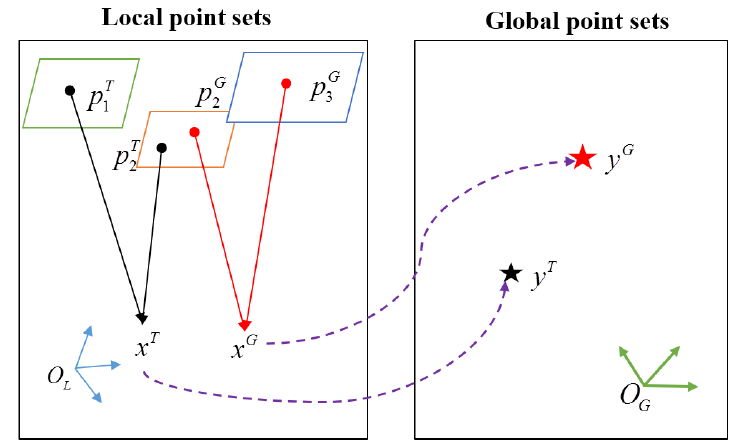
Figure 4. The workflow of manufacturing two point sets of synthetic data using the bundle adjustment (BA)